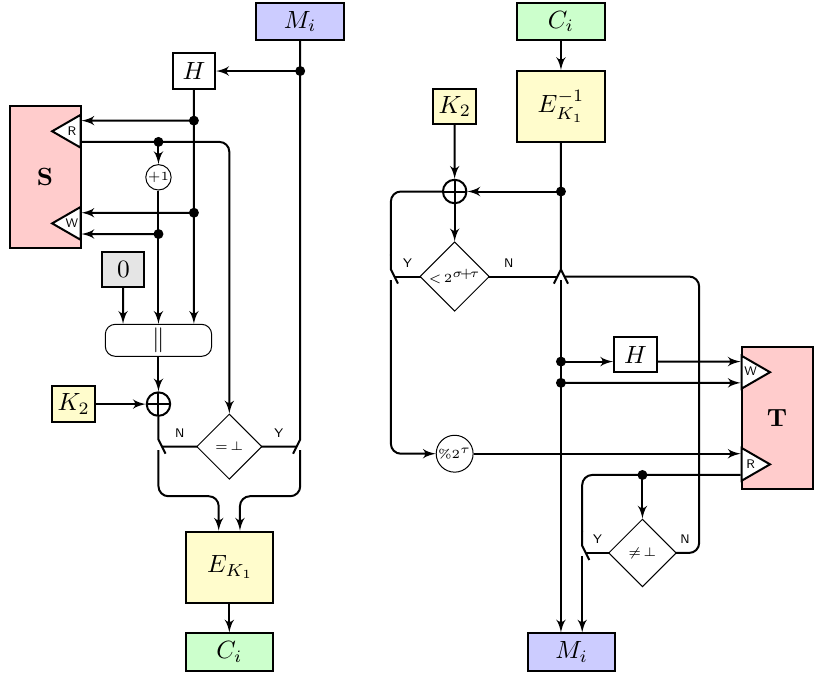
Figure 5: Schematic description of how encryption and decryption algorithms of SCB [ E, H ] process each block (we assume that ⊥ + 1 . =